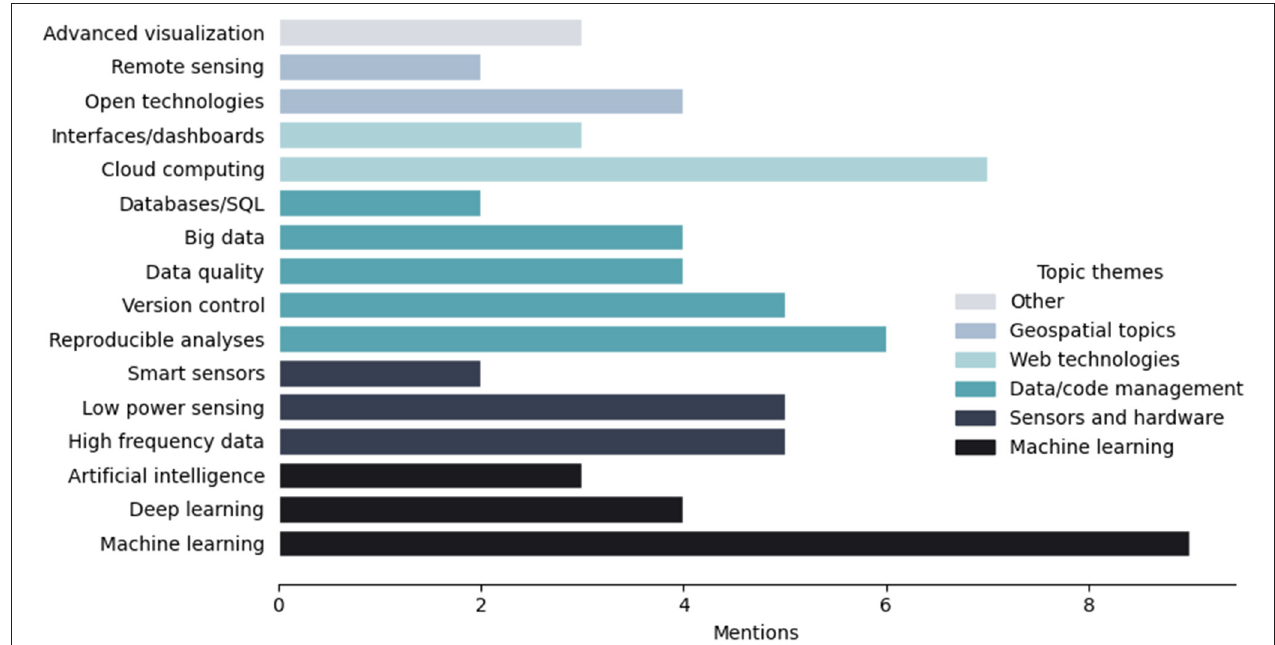
FIGURE 2 | Count of mentions related to subjects of growing importance sorted by thematic topics.